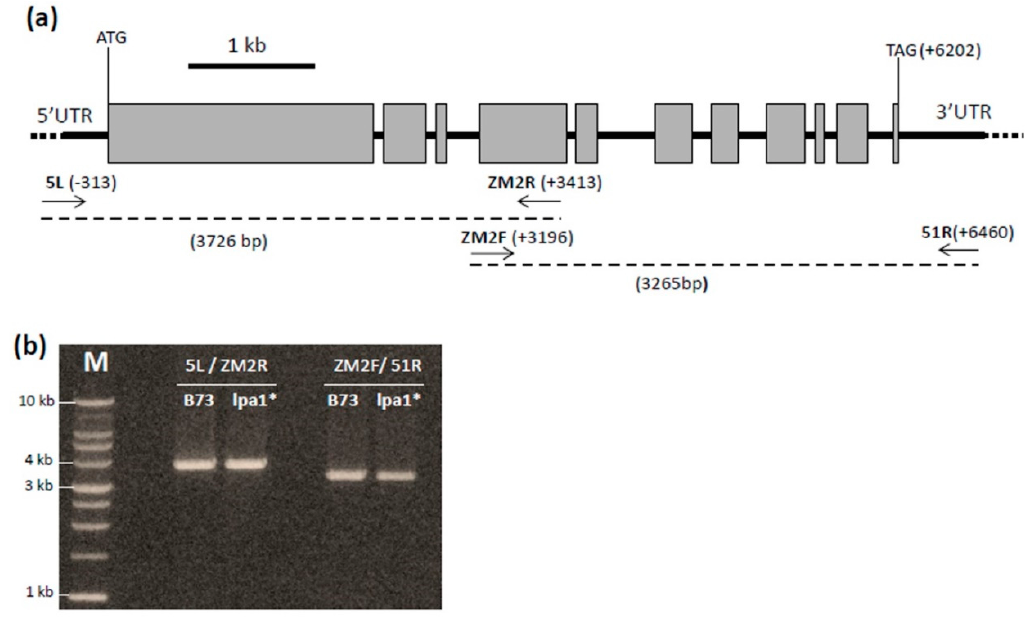
Figure 5. ( a ) Structure of the ZmMRP4 gene. The primers used to amplify the coding sequence of ZmMRP4 gene are indicated by the arrows. ( b ) Agarose gel showing the amplicons obtained amplifying wt (B73) and mutant (lpa1-5525) genomic DNA with primers 5L/ZM2r and ZM2F/51R.